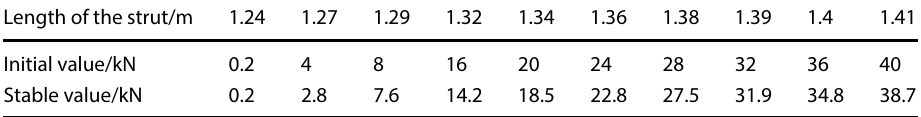
Table 3 Prestress loss